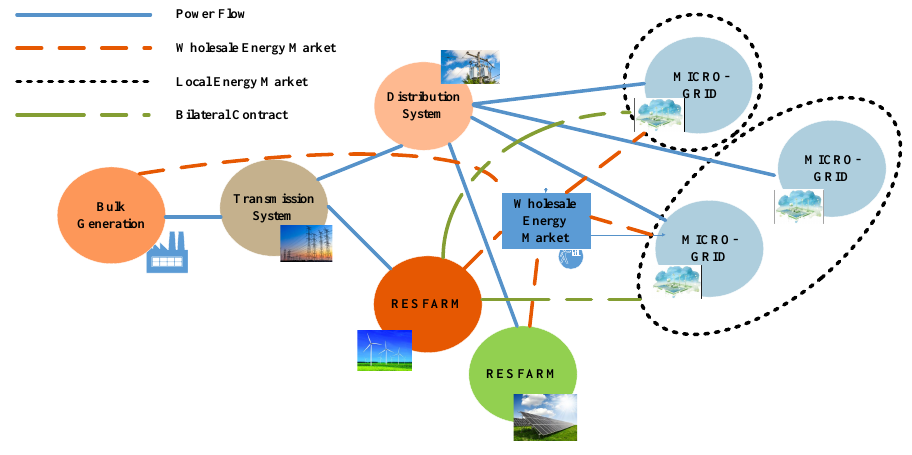
Figure 3. Transactive power system concept